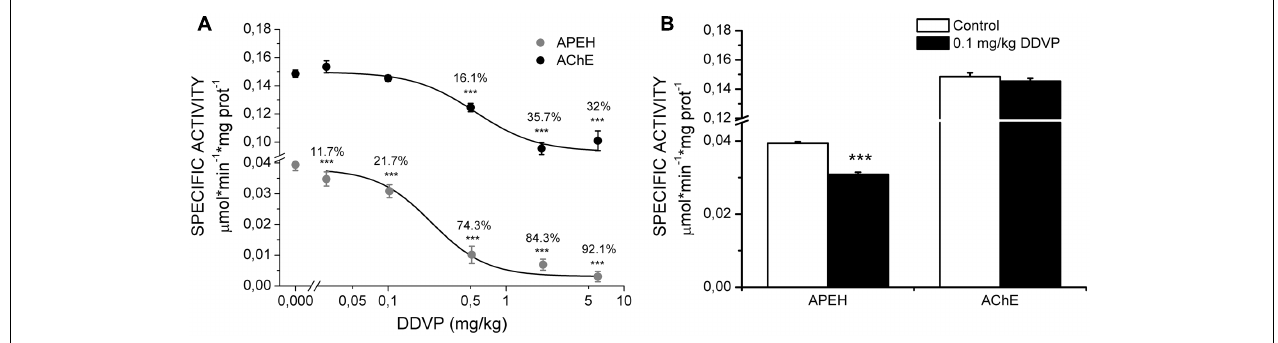
FIGURE 2 | Quantification of specific activities of APEH and AChE. (A) Dose–response curves for the inhibition of hippocampal specific activities of APEH (gray circles) and AChE (black circles) upon administration of various doses of DDVP to different groups of animals. Significant percentages of inhibition are showed above each activity point. The dose–response curves of inhibition were adjusted to a Hill equation (the IC 50 values for APEH and AChE were 0.234 ± 0.092 mg/kg and 0.546 ± 0.146 mg/kg, respectively. (B) Specific activities for the two enzymes under control conditions and at a DDVP dose of 0.1 mg/kg. Only APEH was significantly inhibited at this dose. ∗∗∗ p < 0.001, unpaired t